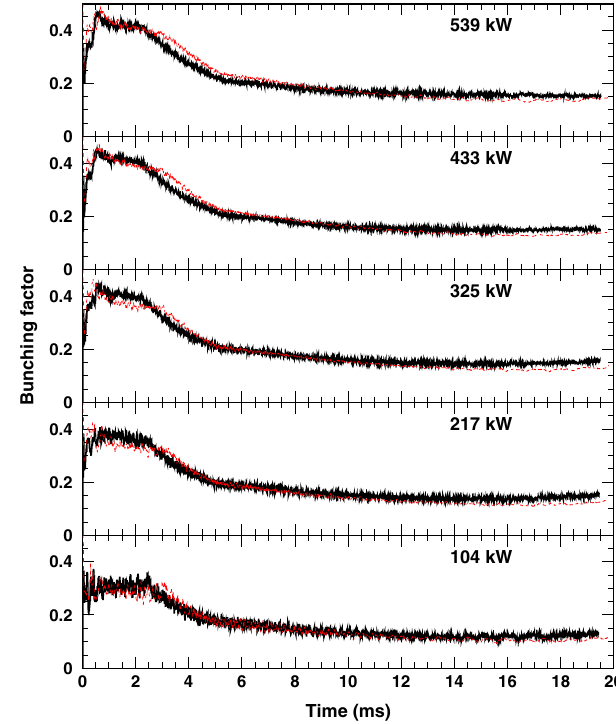
FIG. 13. Transverse beam profiles at 3 GeV measured in the extraction beam transport line with the injection painting param- eter of ID 8 for various beam intensities from 104 to 539 kW, where the dashed red curves are the corresponding numerical simulation results.